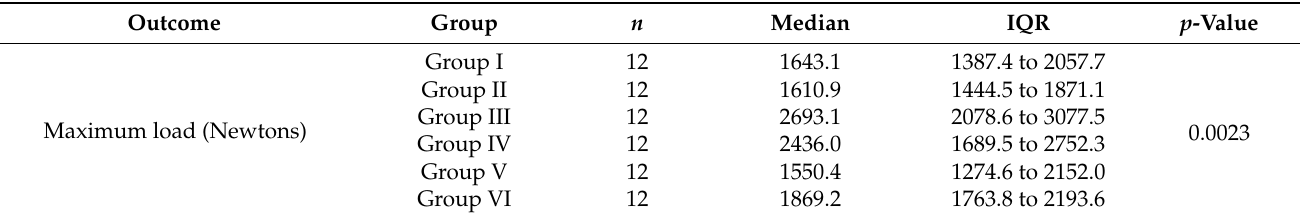
Table 2. Comparison of the maximum load between the